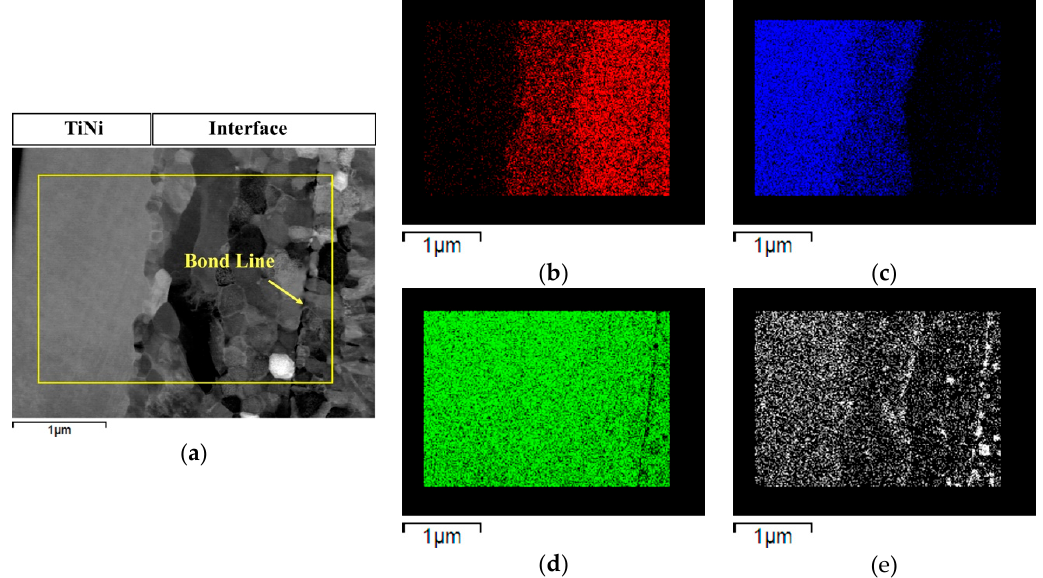
Figure 4. ( a ) Scanning transmission electron microscopy (STEM) image of the TiNi/Ti6Al4V interface close to the TiNi alloy and EDS elemental maps of ( b ) Al, ( c ) Ti, ( d ) Ni and ( e ) V.